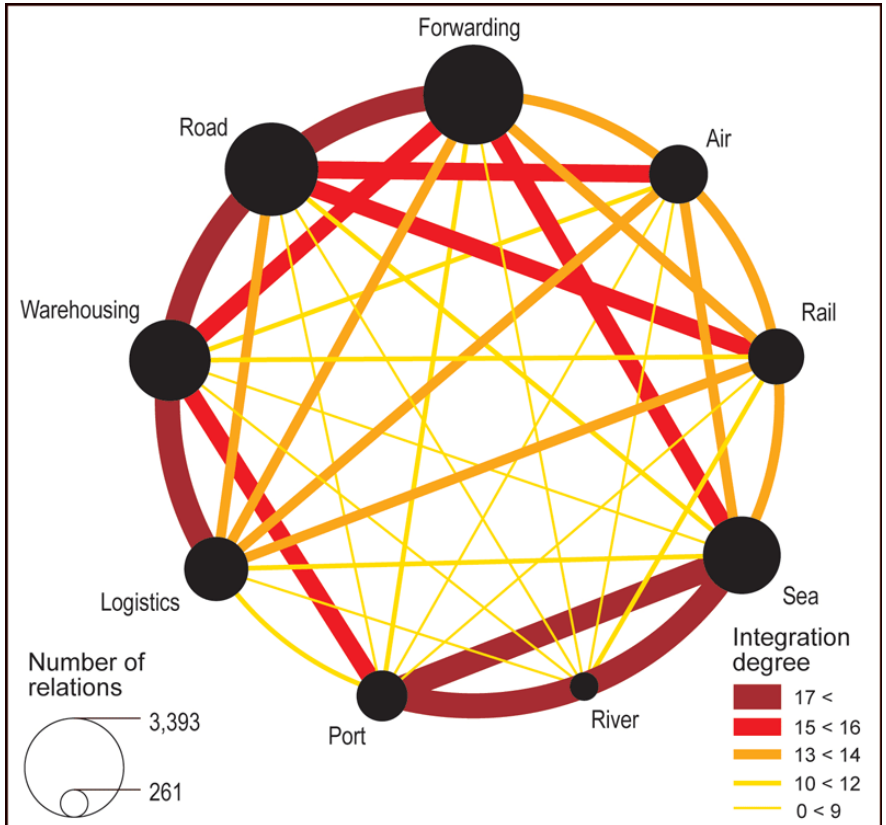
Figure 3. Integration levels among main transport